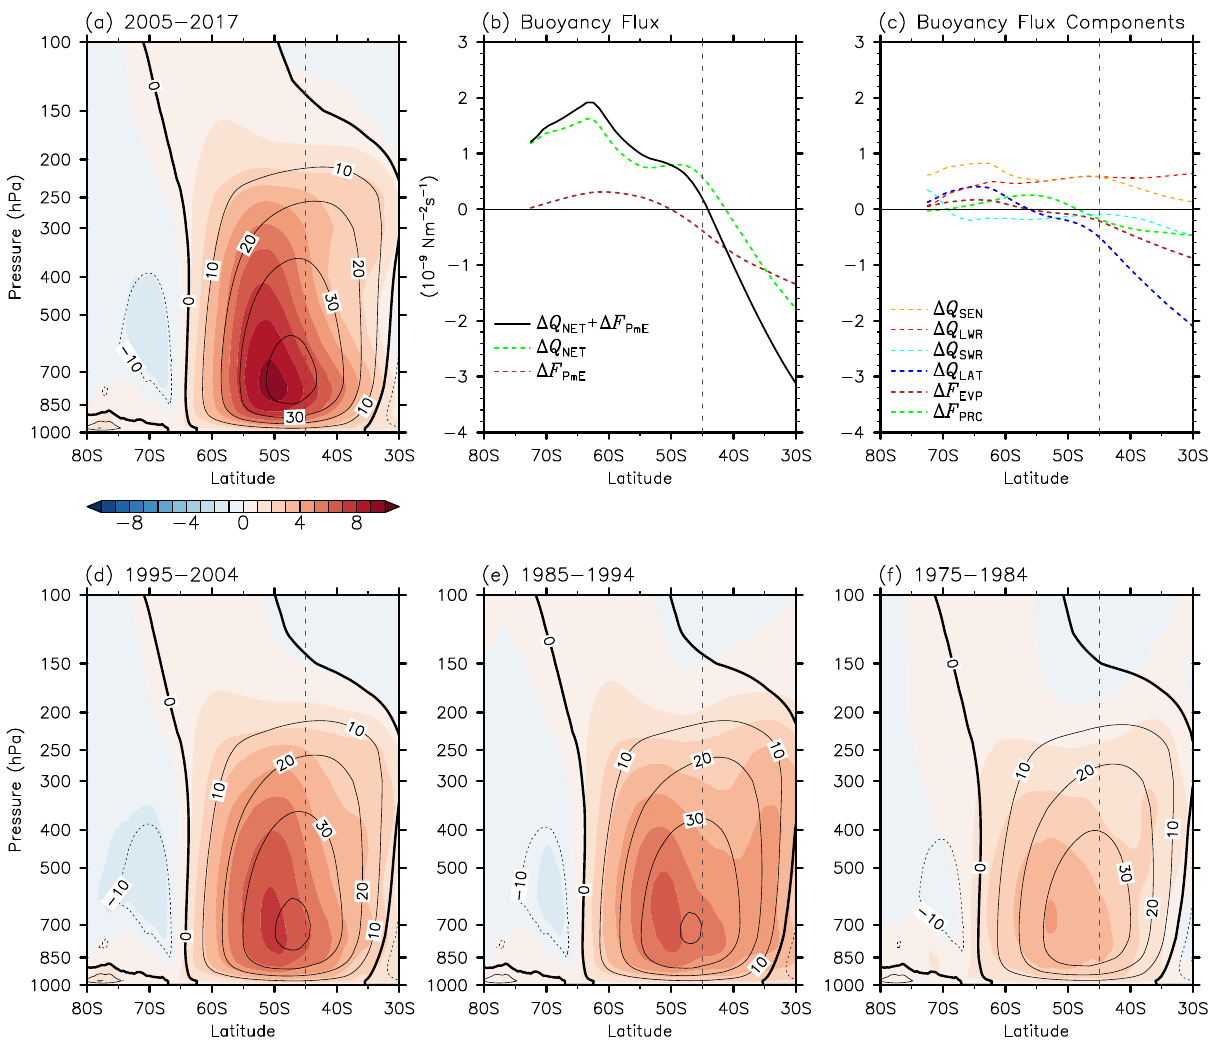
Fig. 5 SH Polar and Ferrel Cells and surface buoyancy fl ux. Mass transport streamfunction (10 9 kg s − 1 ) for the SH Polar and Ferrel cells (contours) and its ERA5. Zonally averaged changes in ( b ) net buoyancy fl ux ( Δ Q NET + Δ F PmE ) and its associated heat and freshwater fl ux, and c heat and freshwater fl ux ( c ) indicate the changes in net surface heat fl ux, sensible heat fl ux, longwave radiation, shortwave radiation, latent heat fl ux, net freshwater fl ux, precipitation and evaporation, respectively. All values in ( b ) and ( c ) are smoothed, and converted into buoyancy fl ux unit (10 − 9 Nm − 2 s − 1 ) using a simpli fi ed linear equation and assuming that the thermal and saline expansion coef fi cients are constant. A positive fl ux value in ( b ) and ( c ) indicates